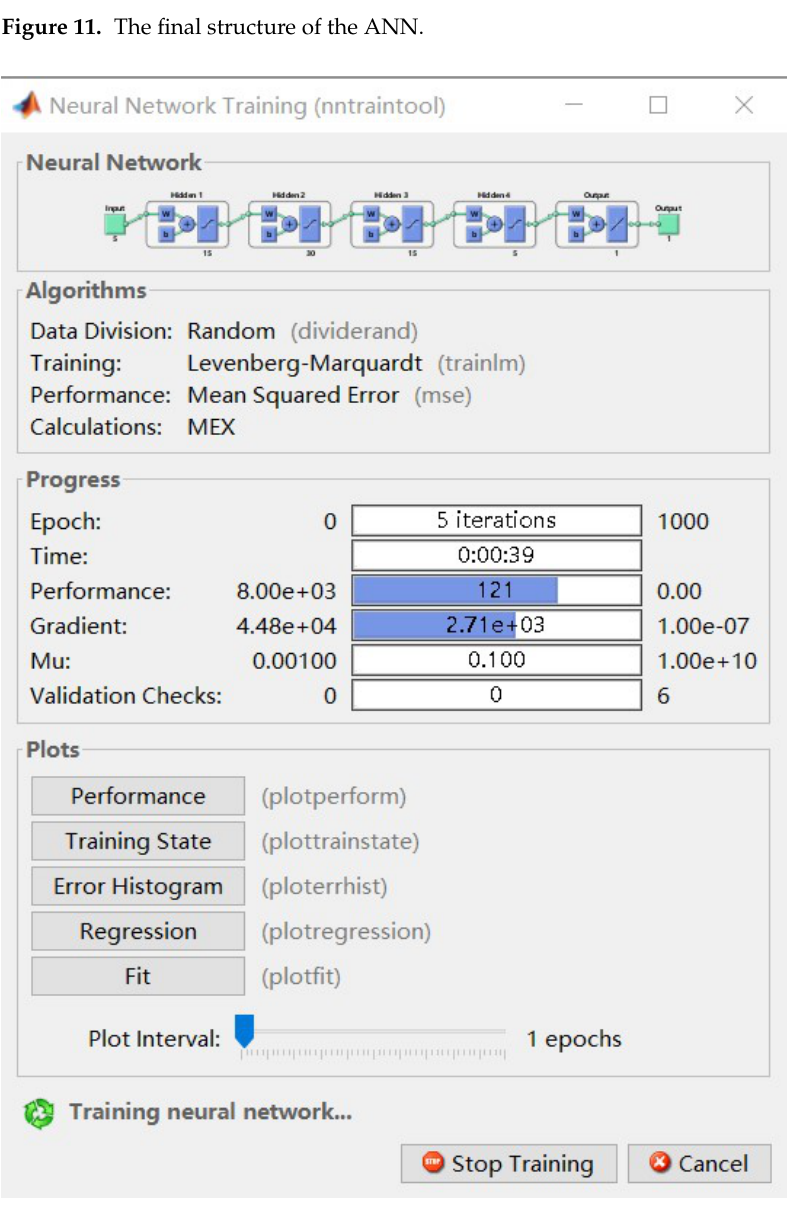
Figure 12. The neural network tool in